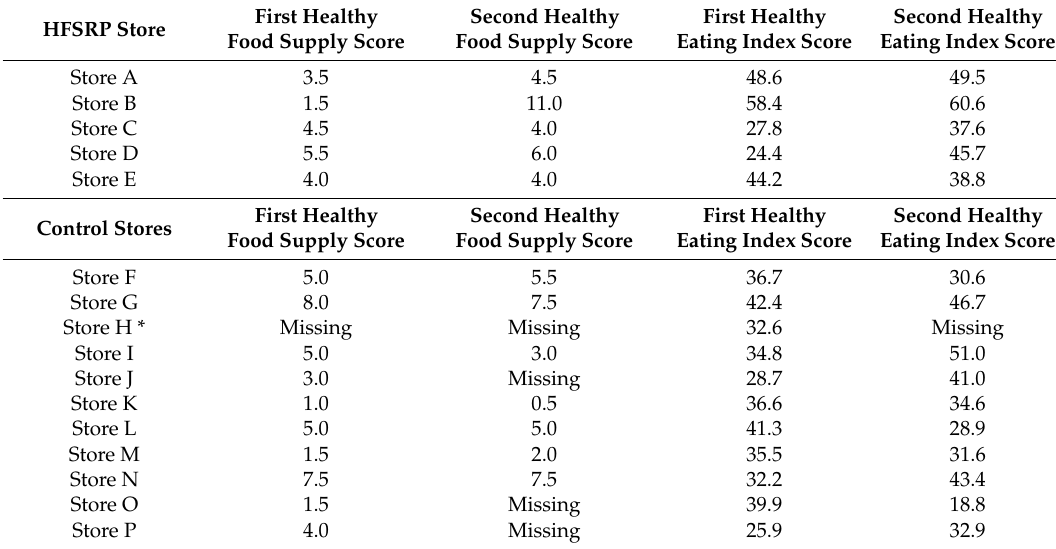
Table 1. Healthy Food Supply Scores, Healthy Eating Index Scores among Healthy Food Small Retailer Program (HFSRP) and Control